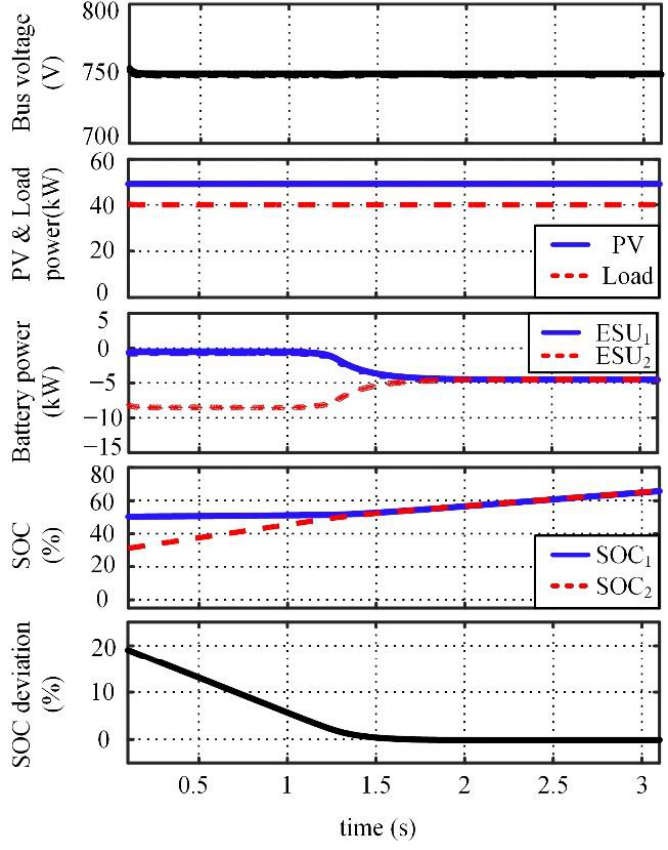
Figure 8. Waveforms of P ≤ P cmax in charging. 4.1. Coordinated Control Diagram of DC Microgrid